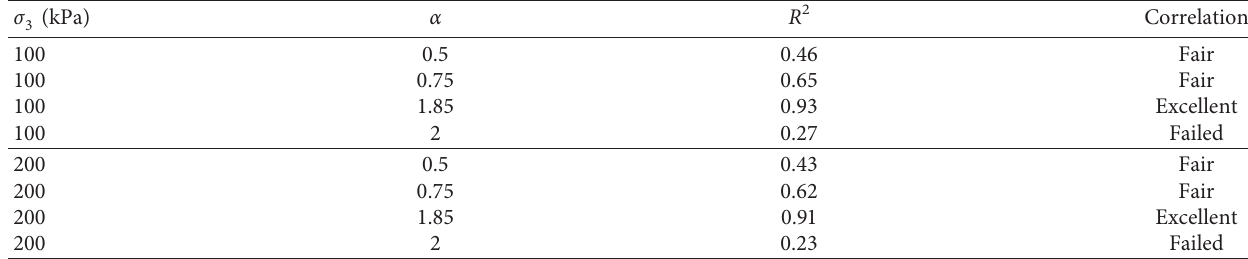
Table 2: Correlation coefficient of model.